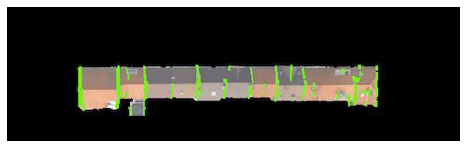
Figure 8 . Vertical or close to vertical Hough lines